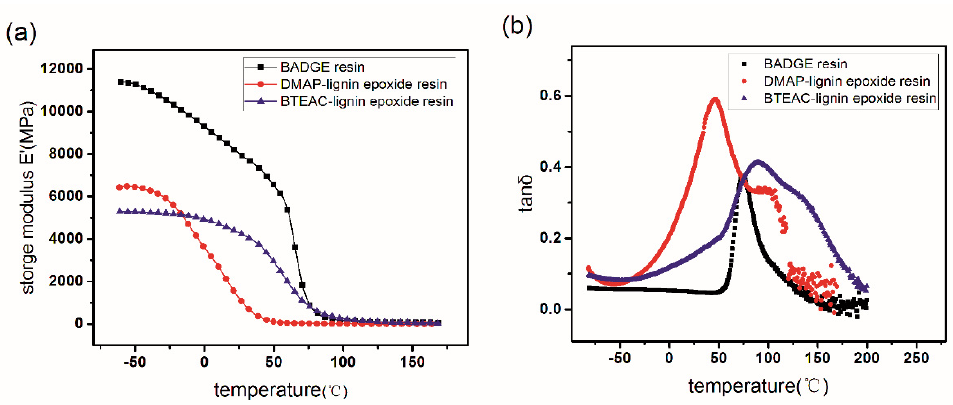
Figure 3. The storage modulus ( a ) and tan δ ( b ) measured for the DMAP-lignin epoxide, BTEAC- lignin epoxide, and BADGE resins as a function of